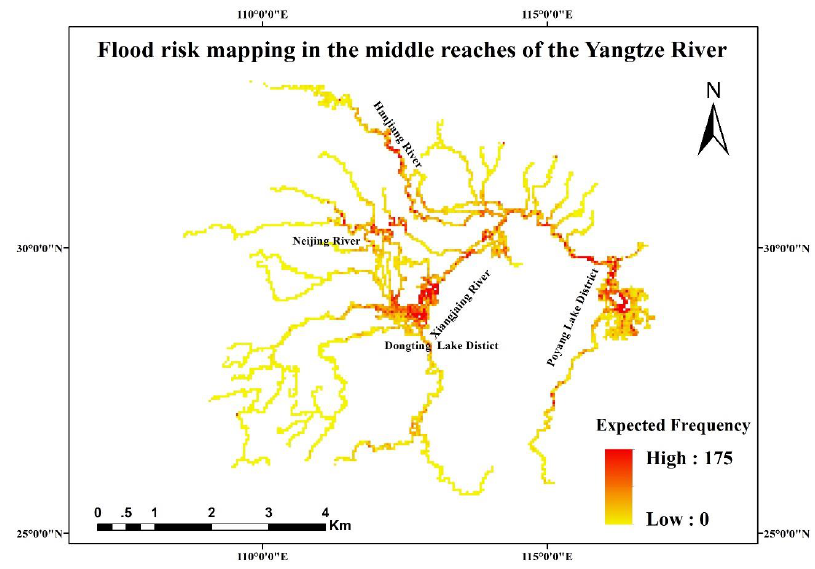
Figure 18. Predicted frequency of flood alarming risk.